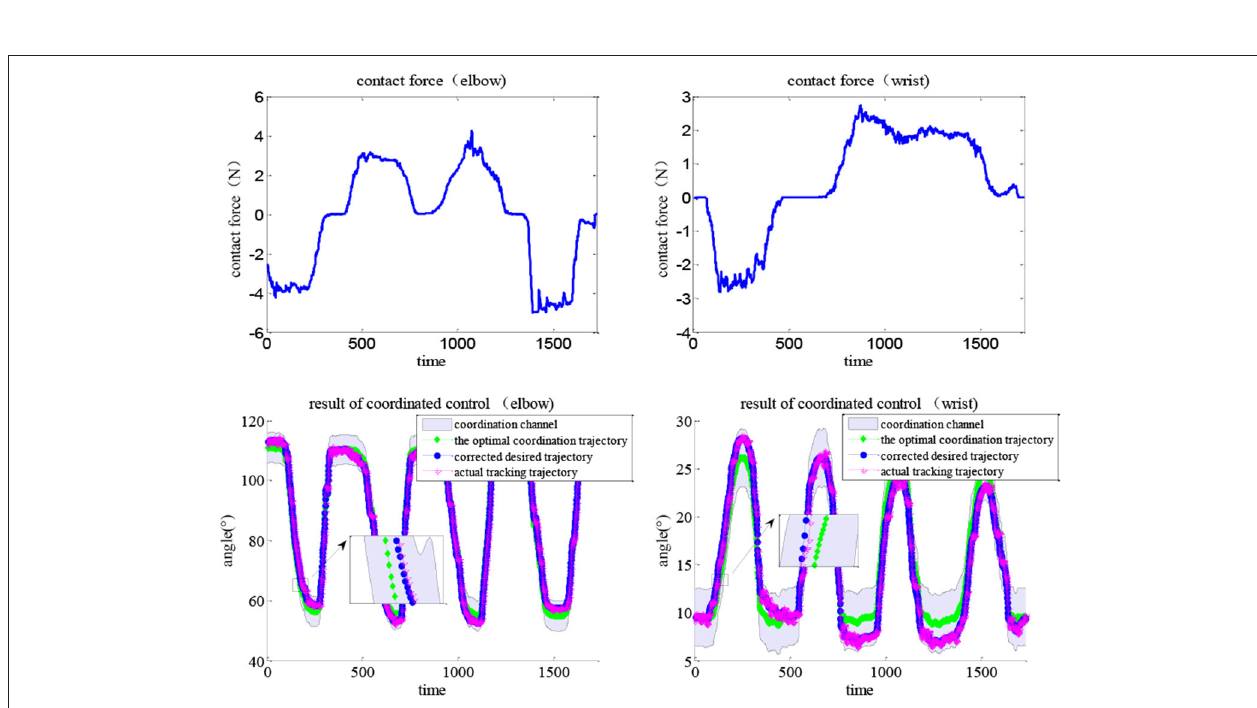
FIGURE 15 | Results of the coordination control with human contact force under Task 1, lines indicating the coordination channel, the optimal trajectory, the corrected trajectory ( via impedance control), and the actual tracking trajectory ( via MISO-IMFAC).